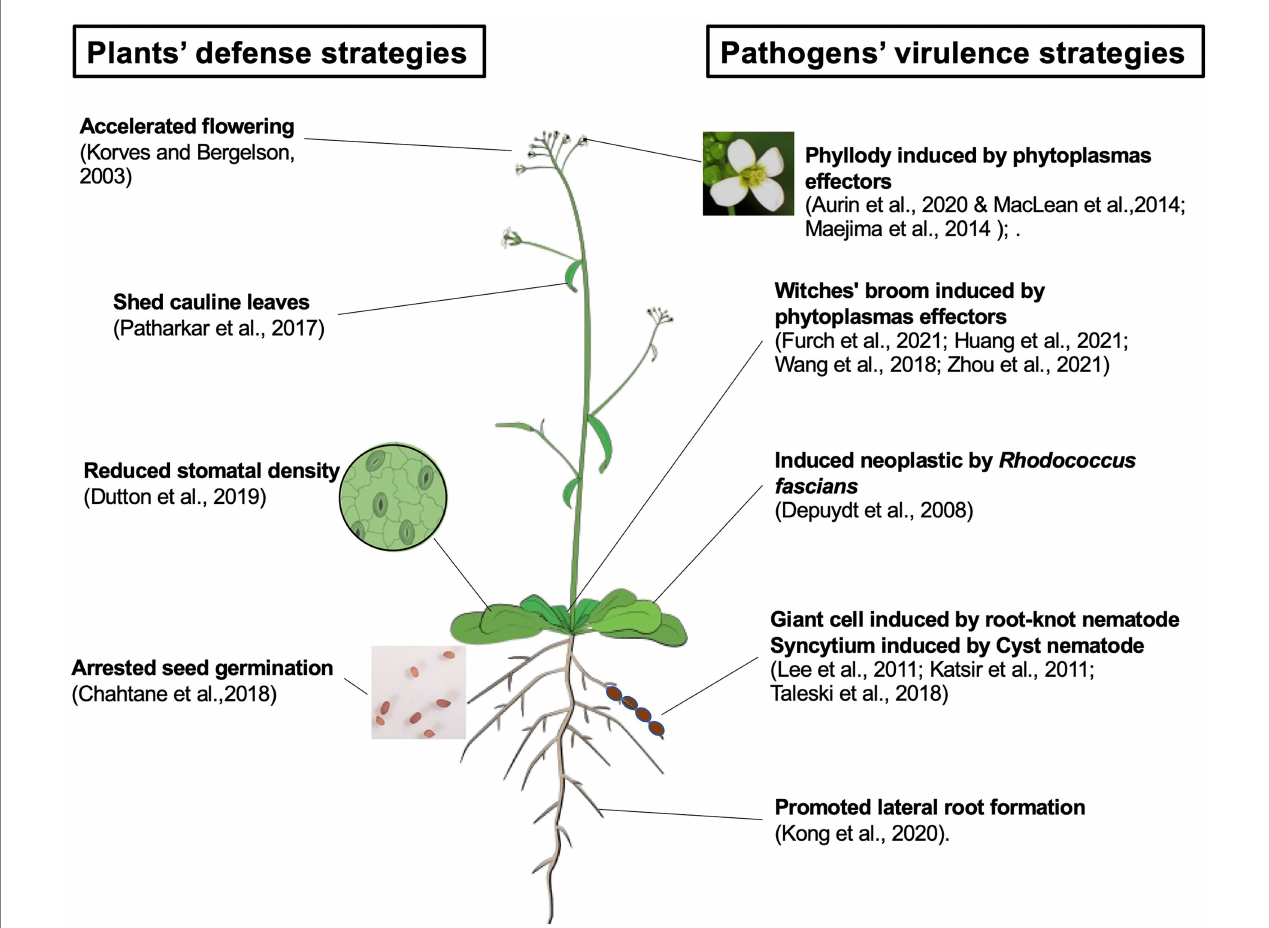
FIGURE 1 Pathogens triggered changes in plants development. Pathogen-triggered development changes in plants can be results of active defense strategies, including accelerating flowering time, shed its cauline leaves, reduced the stomatal density, and arrest seed germination. Pathogens’ virulence strategies also target host development. Such changes can be achieved by effectors, such as phytoplasma effector induced phyllody and witches’ broom, or hormone mimics including neoplastic growth induced by Rhodococcus fascians and giant cell/syncytium formed during nematode infection. The Arabidopsis model was cited from Illustrations, Plant (2017): Shoot illustrations. Figshare. Collection.